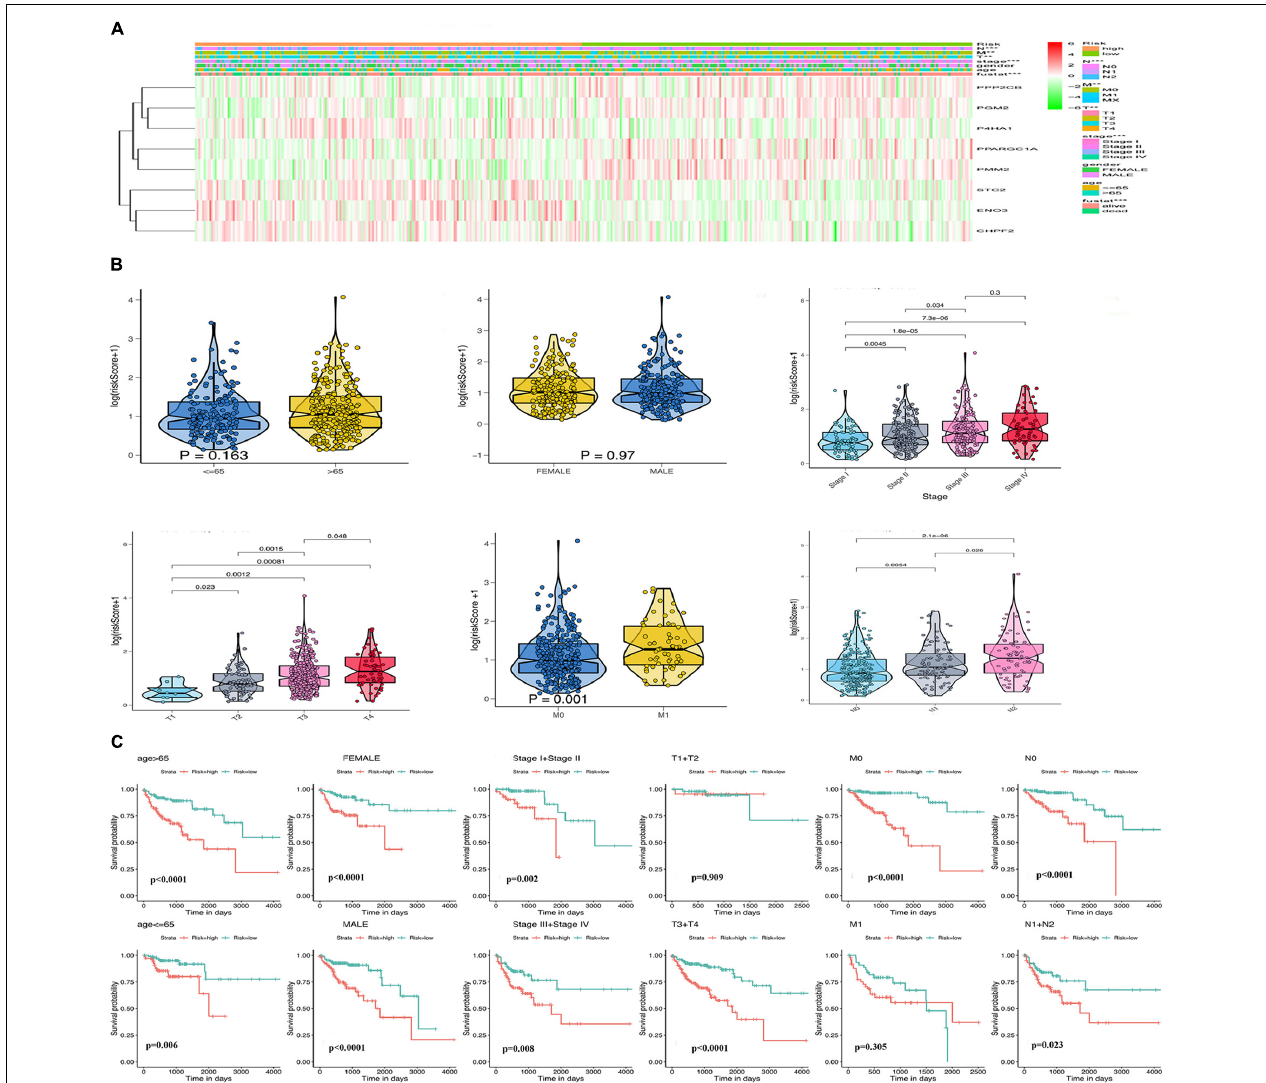
FIGURE 5 | Relationship of the GRG signature with clinicopathological characteristics in The Cancer Genome Atlas (TCGA) data. (A) Heatmap of the differential expression of the eight GRGs. (B) Box plots showing risk score distribution of different clinical characteristics of the colon adenocarcinoma (COAD) tumors. (C) The GRG risk model predicts the overall survival (OS) rate of patients with colon cancer in multiple clinical subgroups.